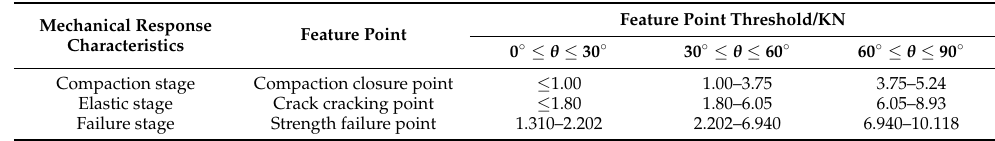
Table 2. Mechanical action stages and threshold values of characteristic points of samples with different layer orientations.